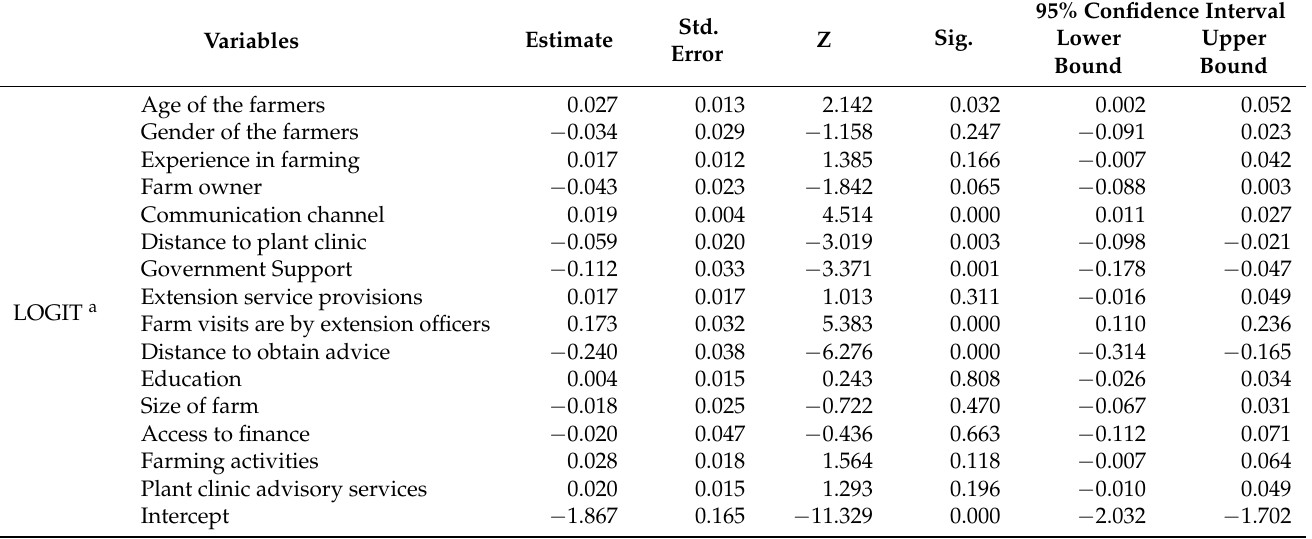
Table 4. Parameter estimates of logit regression model of factors influencing smallholder farmers’ awareness of plant health clinic advisory services (n =